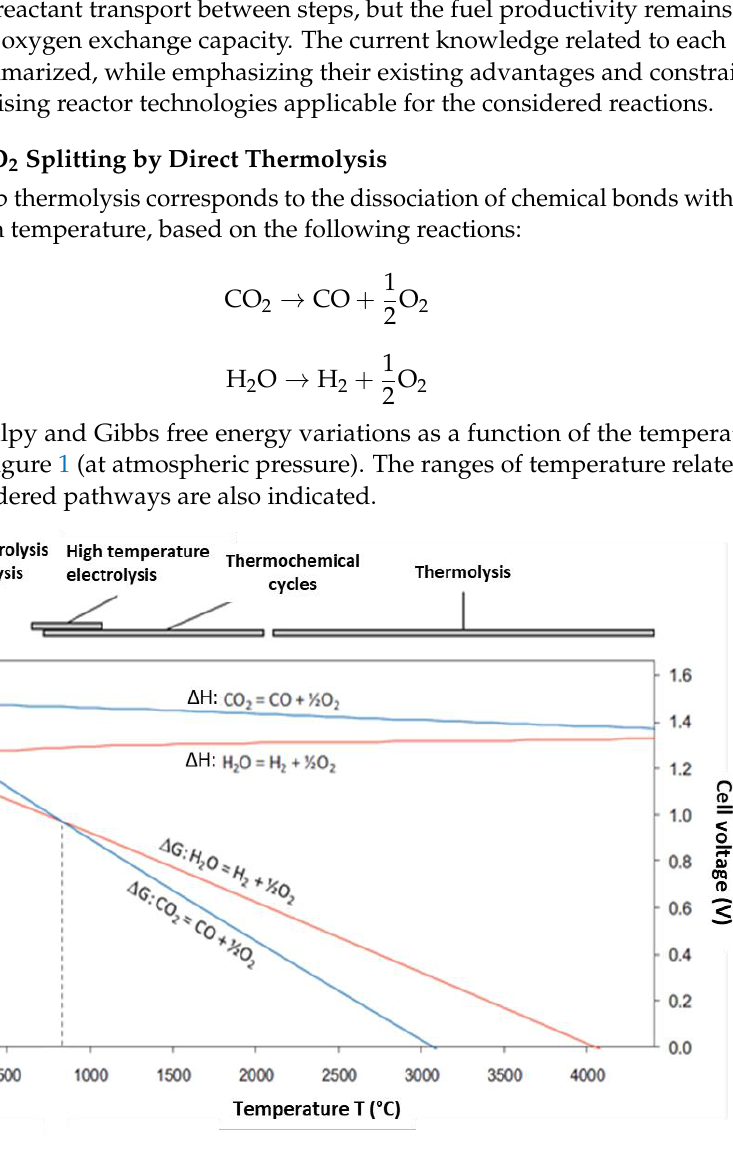
Figure 1. Variation of enthalpy and Gibbs free energy of thermolysis of CO 2 and H 2 O as a function of the temperature.